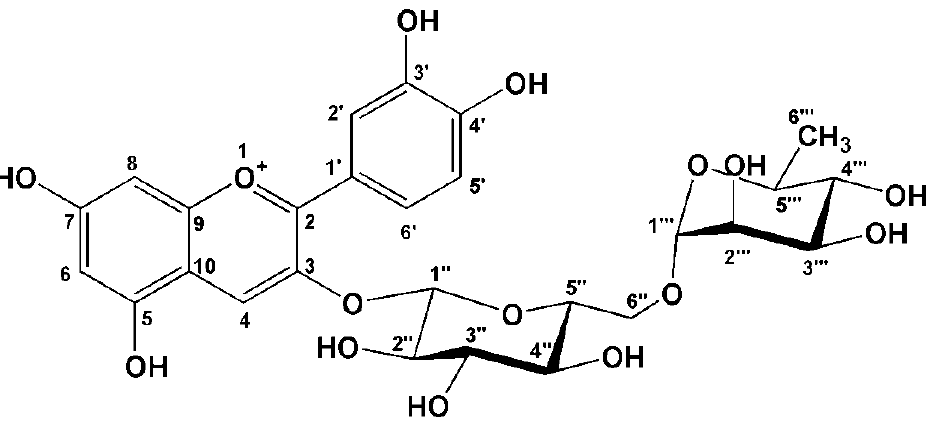
Figure 1. The structure of cyanidin-3-rutinoside